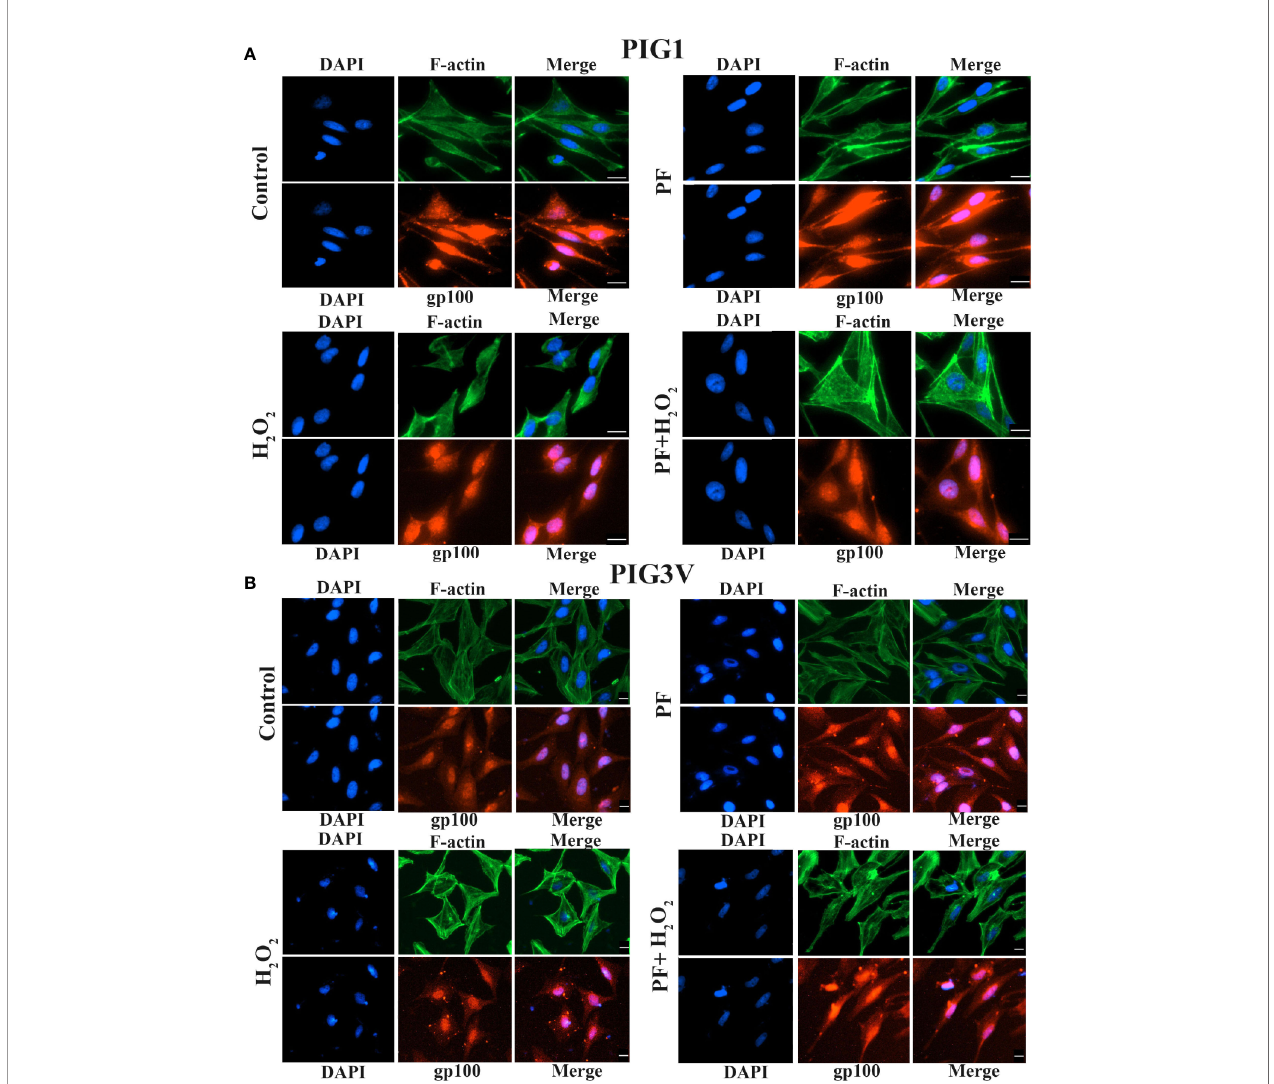
FIGURE 5 | PF promotes dendrite formation and melanosome transport under H 2 O 2 -induced oxidative damage. Melanocytes were exposed to PF for 24 h and were further treated with H 2 O 2 for another 24 h. The dendrite lengths were increased and contained more melanosomes in both stressed PIG1 (A) and PIG3V (B) when pre-treated with PF compared to H 2 O 2 treated only. Then cells were fi xed and stained with antibodies recognizing F-actin (phalloidin, green) and melanosome (gp100, red). Nuclei were counterstained with DAPI (blue). Immuno fl uorescence was used to determine the localization and expression of melanosomes and F-actin in the cells. Scalebar = 20µm. H 2 O 2 , hydrogen peroxide; PF, Paeoni fl